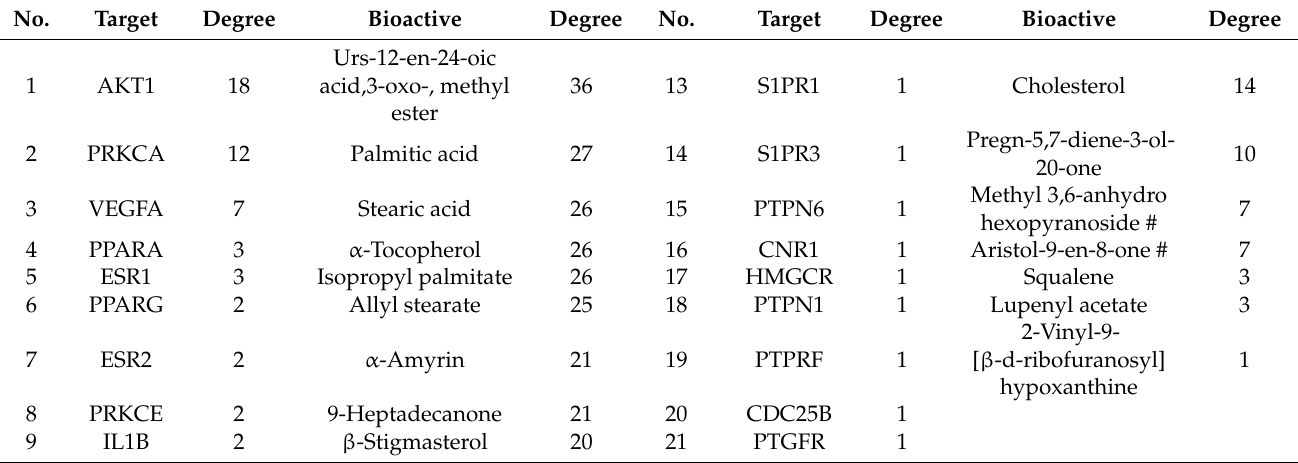
Table 4. The degree value of S–T–B